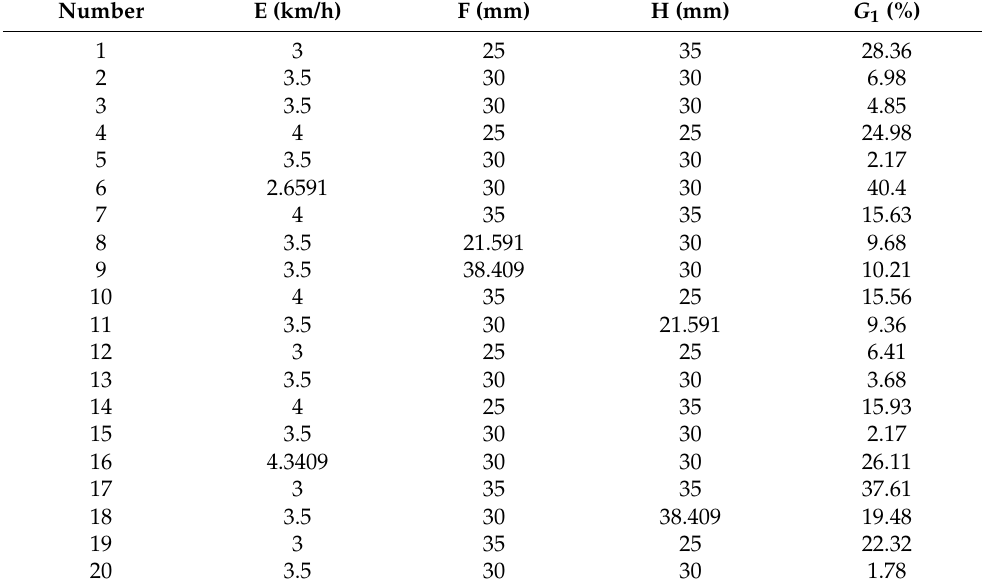
Table 9. Test design form and test data for operating parameters.